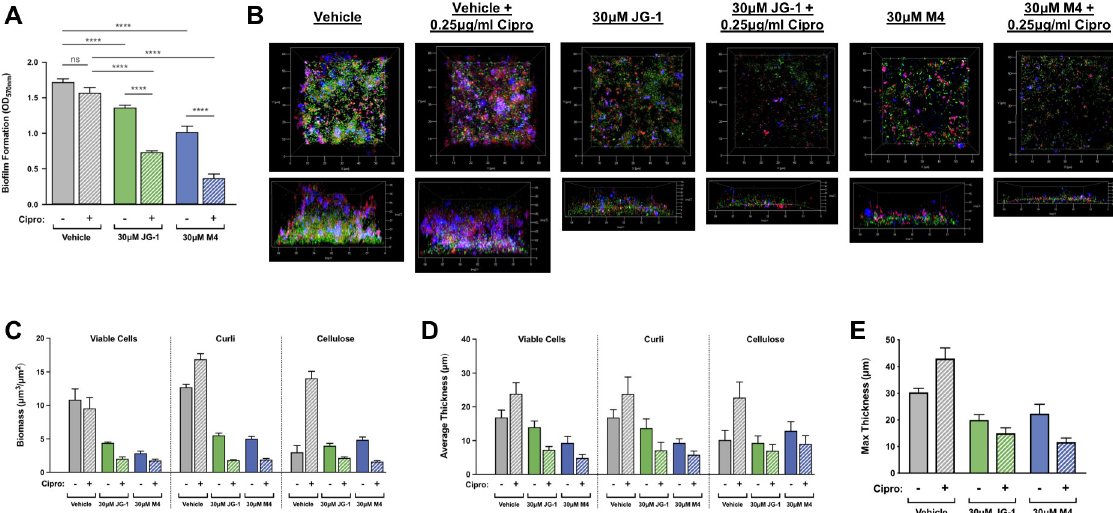
Fig 4. Concurrent treatment with ciprofloxacin (cipro) enhances the anti-biofilm capabilities of JG-1 and M4. A. S . Typhimurium biofilms were grown in microtiter plates for 24 h, then treated for 24h with a vehicle control (DMSO), 0.25 μ g/mL cipro, 30 μ M JG-1/M4, or a combination of 0.25 μ g/mL cipro + 30 μ M JG-1/M4. Biofilm formation was measured using the crystal violet assay and graphed as the mean +/- SD. B. S . Typhimurium biofilms were grown in 8-well glass-bottom chamber slides for 96 h, then treated for 24h with a vehicle control (DMSO), 0.25 μ g/mL cipro, 30 μ M JG-1/M4, or a combination of 0.25 μ g/mL cipro + 30 μ M JG-1/M4. Biofilms were stained with a combination of Syto9 and Calcofluor white in order to visualize viable cells (green) and cellulose (blue), respectively, prior to fixation in 2% PFA. Curli fimbriae (red) were visualized using a human α -amyloid mAb. Representative z-stacks (N = 5 per treatment) were captured at 100X magnification using a Zeiss LSM 800 laser scanning confocal microscope. C–E. COMSTAT2 software was used to calculate the biomass (C) , average thickness (D) , and maximum thickness (E) of biofilm z-stacks for each individual component (cells, cellulose, and curli). Data are presented as the mean +/- SD.